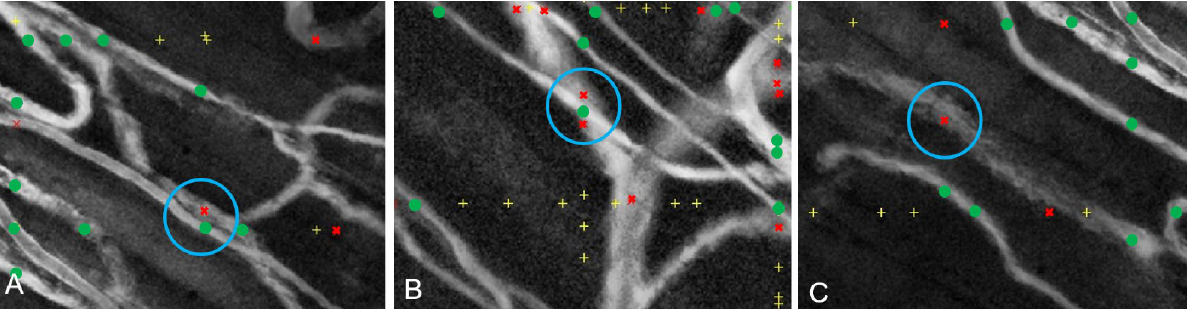
Figure 2. SUDCS Identification. (A) Example of three commonly SUDCS vessel identification errors. Green markers: vessel identified by both the SUDCS and manual analysis. Yellow markers: identified by SUDCS. Red markers: identified by manual analysis. (B) Two adjacent vessels are shown as one vessel by SUDCS. (C) Two vessels intersecting each other are shown as one vessel by SUDCS. Poorly outlined vessel structure due to vessel depth prevents SUDCS from detecting vessel 45,46